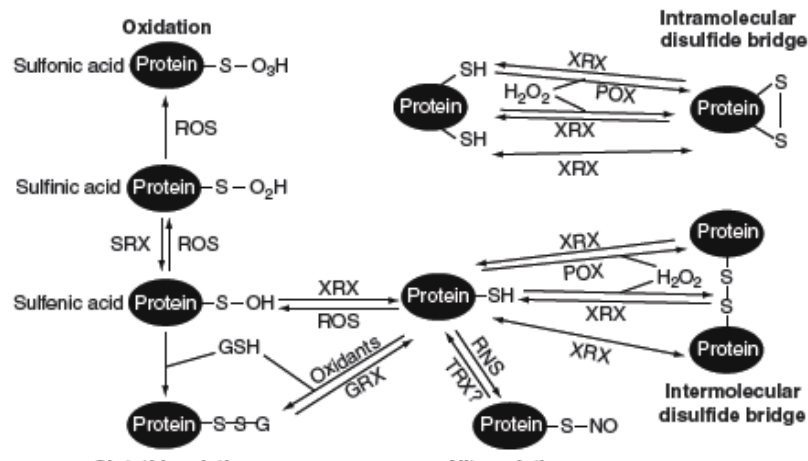
Figure 3. Oxidation and reduction of protein thiols. Under oxidative conditions, free and accessible protein thiols undergo several different posttranslational modifications, which can be either reversible or not. Protein cysteines can be oxidized by ROS into sulfenic acid (SOH), which can be reduced by XRX (GRX or TRX). Further oxidation of sulfenic acid by ROS can result in the formation of sulfinic acid (SO 2 H), which can be reversed by sulfiredoxins (SRX) or irreversibly oxidized to sulfonic acid (SO 3 H). The presence of oxidants and/or GSH allows the glutathionylation of protein cysteines to occur through different mechanisms. Deglutathionylation can be catalyzed by GRX. Reversible formation of intra-/inter-molecular disulfide bridges is mediated by XRX. Direct H 2 O 2 -dependent oxidation of cysteines to intra-/intermolecular disulfides and peroxidase (POX)-catalyzed H 2 O 2 sensing can be reversed by XRX. Besides, protein cysteines also undergo nitrosylation in the presence of reactive nitrogen species (RNS), a reversible process that could be catalyzed by TRX. Adapted from